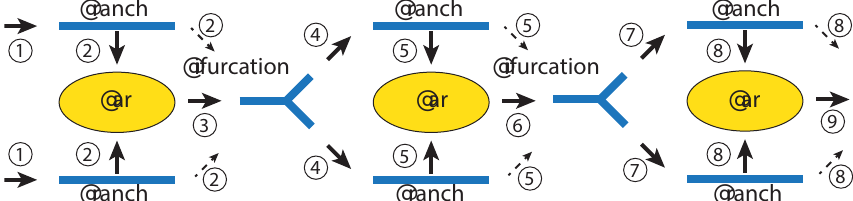
Figure 15. Downstream propagation of the effects of a disturbance through a braiding river: a change in flow and sediment transport through branches affects bar reshaping, bar reshaping affects the bifurcation stability and asymmetry, and these in turn affect the downstream branches. Additionally, the change in flow through the branches directly affects the downstream bifurcation, but the effect of this on the morphology is relatively small. Numbers indicate the sequence of effect with